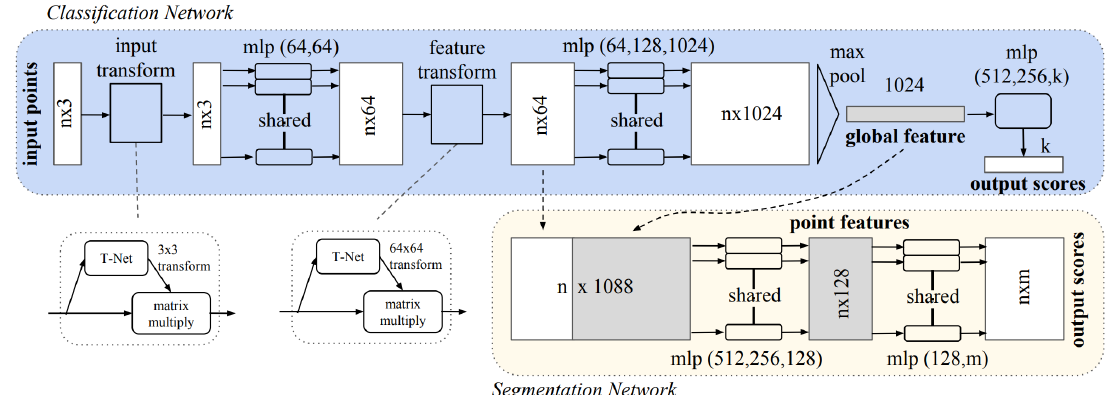
Figure 6. PointNet classification and segmentation network architectures. The network consumes raw x , y , z point cloud data of size n × 3. T-Net is implemented to learn input permutations